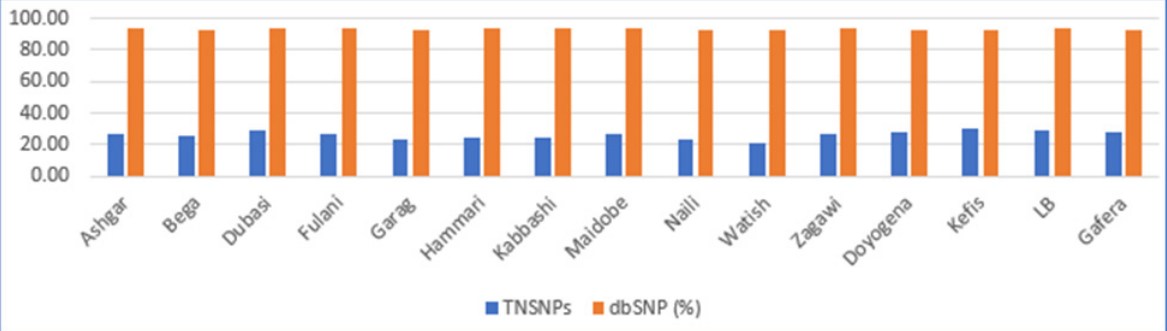
Figure 2. SNP statistics for each sheep population analyzed (134 sheep samples). TNSNPs: Total number of SNPs per population; dbSNP: Single Nucleotide Polymorphism Database; LB: Libyan Barbary.